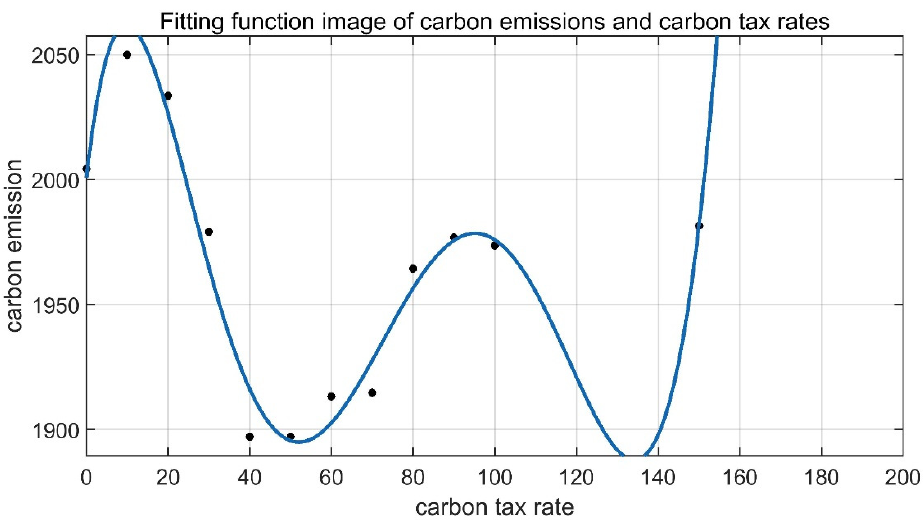
Figure 7. Fitting function of carbon emissions and the carbon tax rate.